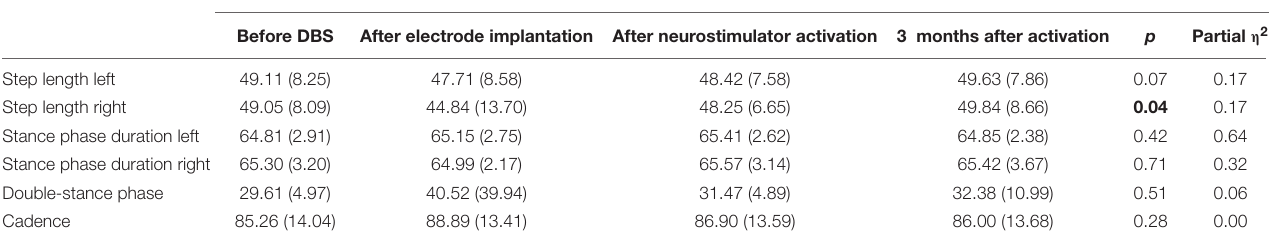
Narrow-based gait 2.5 km/h